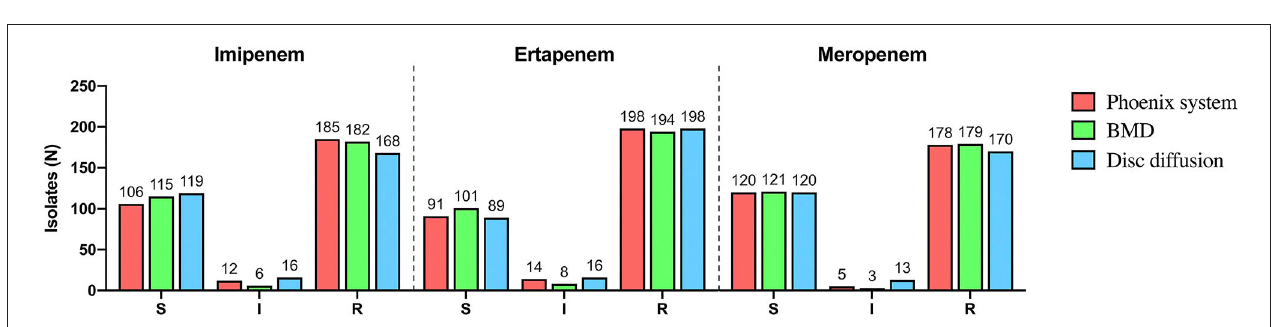
FIGURE 2 | The susceptibility of 303 isolates to imipenem, ertapenem and meropenem with different methods.